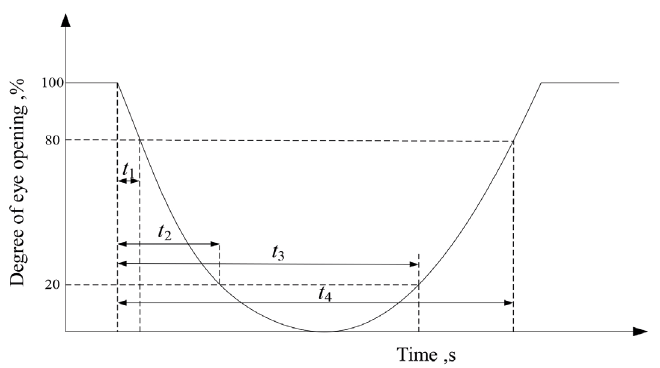
Figure 1. Schematic diagram of